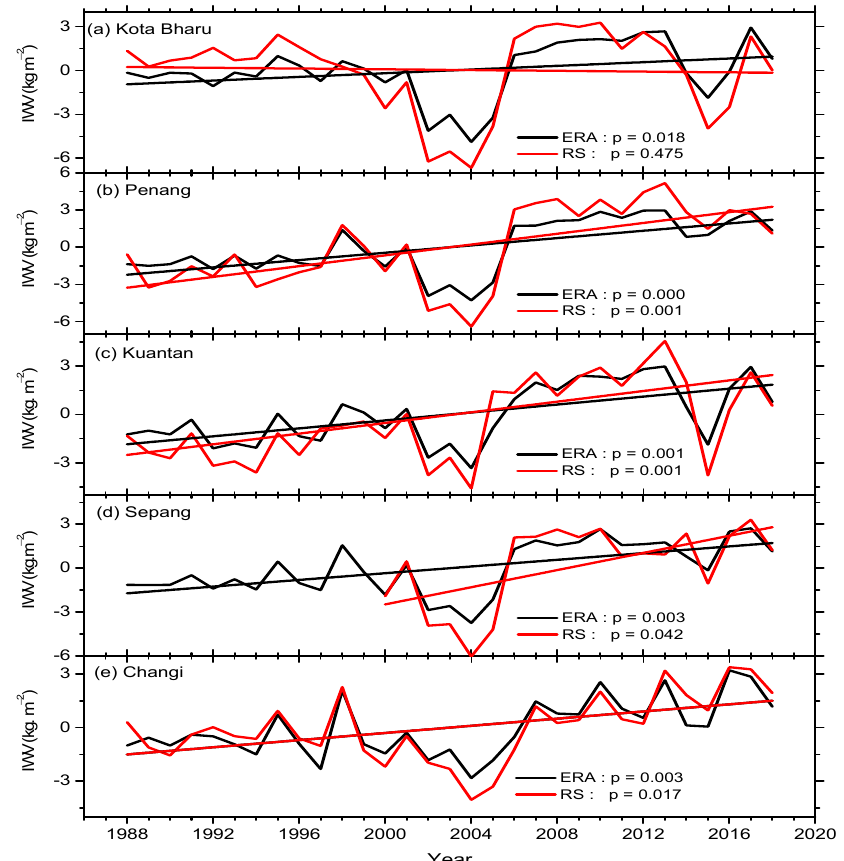
Figure 7. Domain mean of monthly anomalies in annual time series from ERA-Interim IWV (black) interpolated to the nearest station location of the radiosonde IWV (red) with the associated probabilities (p) at 95% confidence interval for the five in situ stations (see Figure 1) .